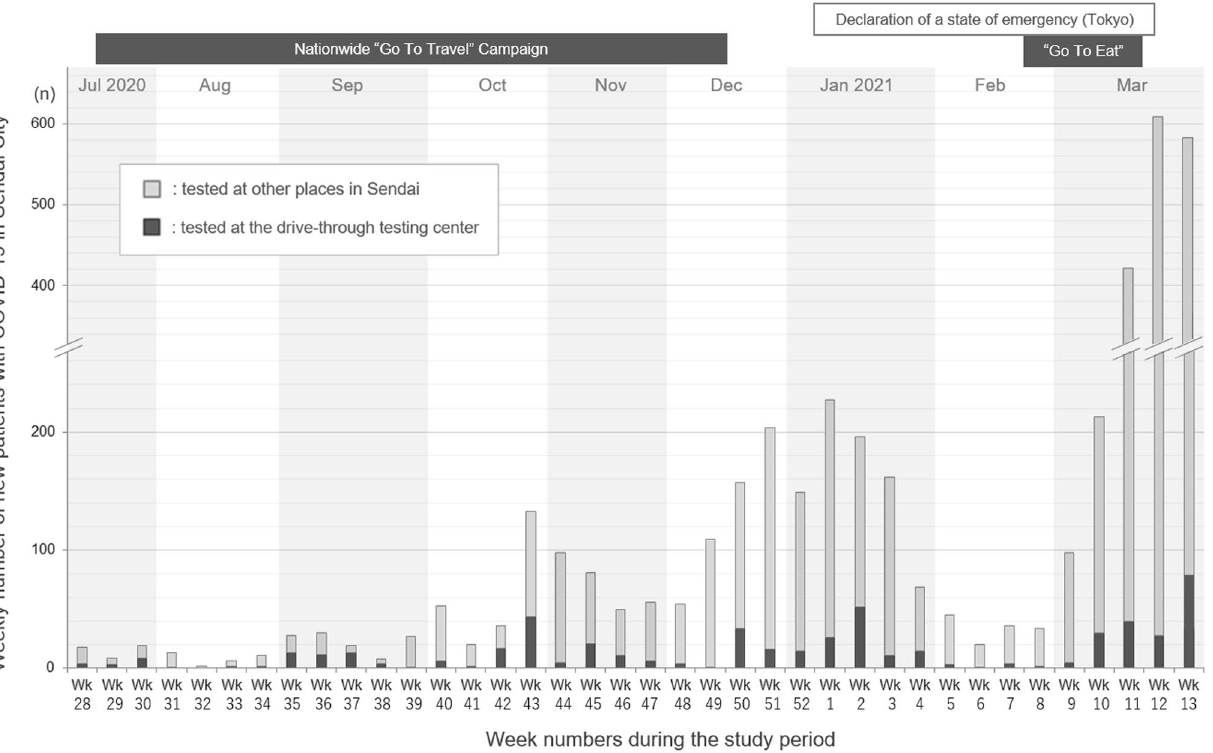
Figure 2. Weekly number of new patients with COVID-19 in Sendai City from July 2020 to March 2021. The black bars illustrate the weekly number of patients newly diagnosed with COVID-19 tested at a drive-through COVID-19 testing center and were initially recruited for this study. The gray bars above the black bars represent the weekly number of patients newly diagnosed with COVID-19 tested at other testing facilities in Sendai City who were not enrolled in this study. The local government announced the daily numbers of new local patients. COVID-19, coronavirus disease; RT-PCR, reverse transcription polymerase chain